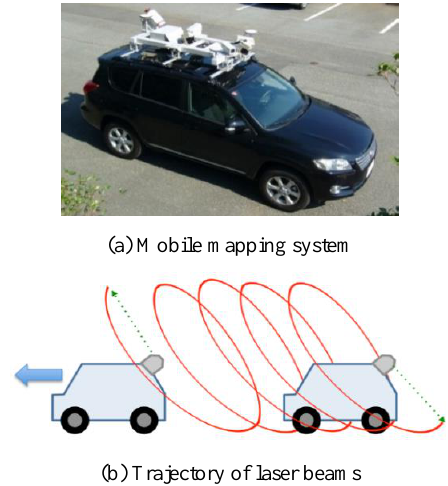
Figure 3. Laser scanning by a mobile mapping system